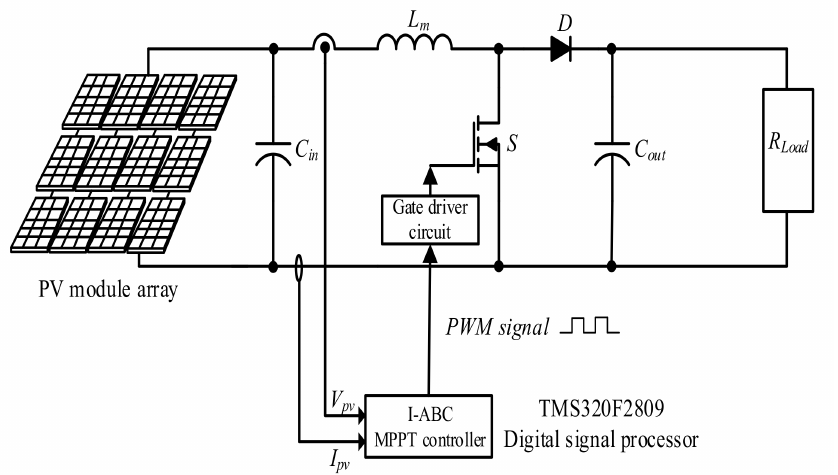
Figure 4. Architecture of the maximum power point tracker for photovoltaic module array based on the I-ABC algorithm.